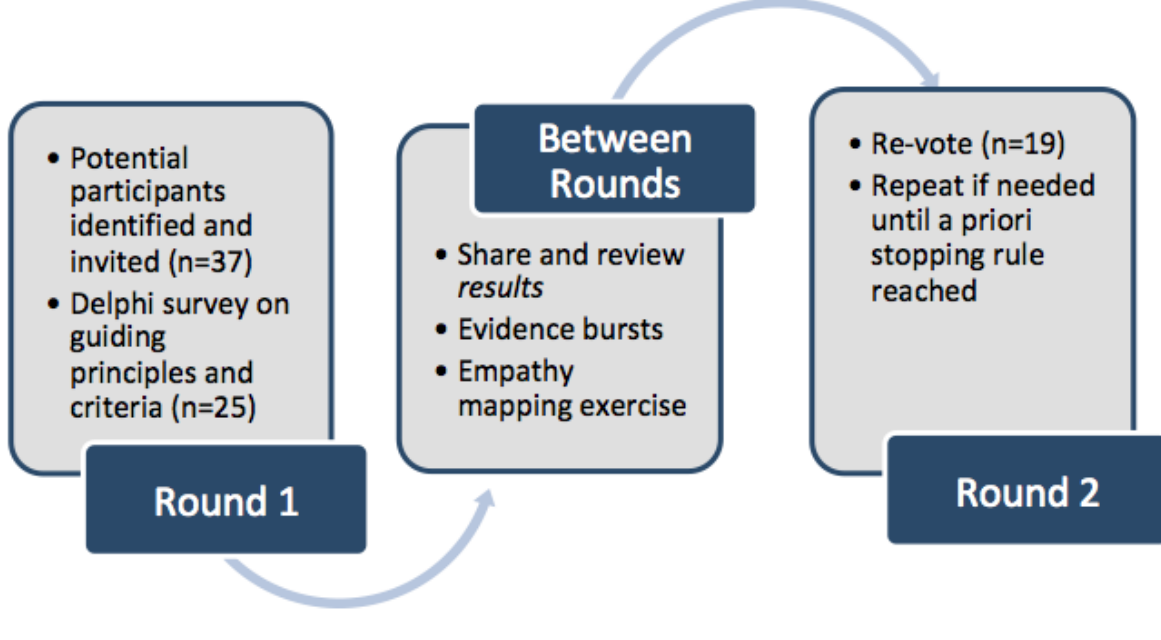
Figure 1. The modified Delphi